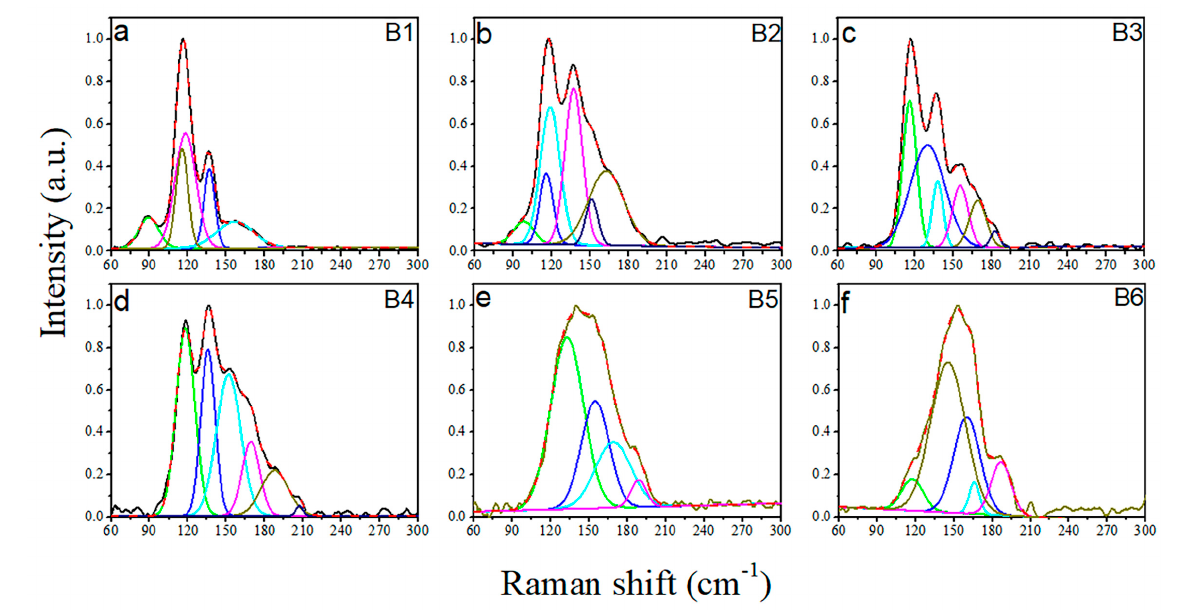
Figure 8. Deconvolution of Raman spectra of B1–B6: Se 10 (Ge 0.1 As 0.9 − y Te y ) 90 glasses: ( a ) B1: Se 10 (Ge 0.1 As 0.1 Te 0.8 ) 90 , ( b ) B2: Se 10 (Ge 0.1 As 0.2 Te 0.7 ) 90 , ( c ) B3: Se 10 (Ge 0.1 As 0.3 Te 0.6 ) 90 , ( d ) B4: Se 10 (Ge 0.1 As 0.4 Te 0.5 ) 90 , ( e ) B5: Se 10 (Ge 0.1 As 0.5 Te 0.4 ) 90 , and ( f ) B6: Se 10 (Ge 0.1 As 0.6 Te 0.3 ) 90 ,